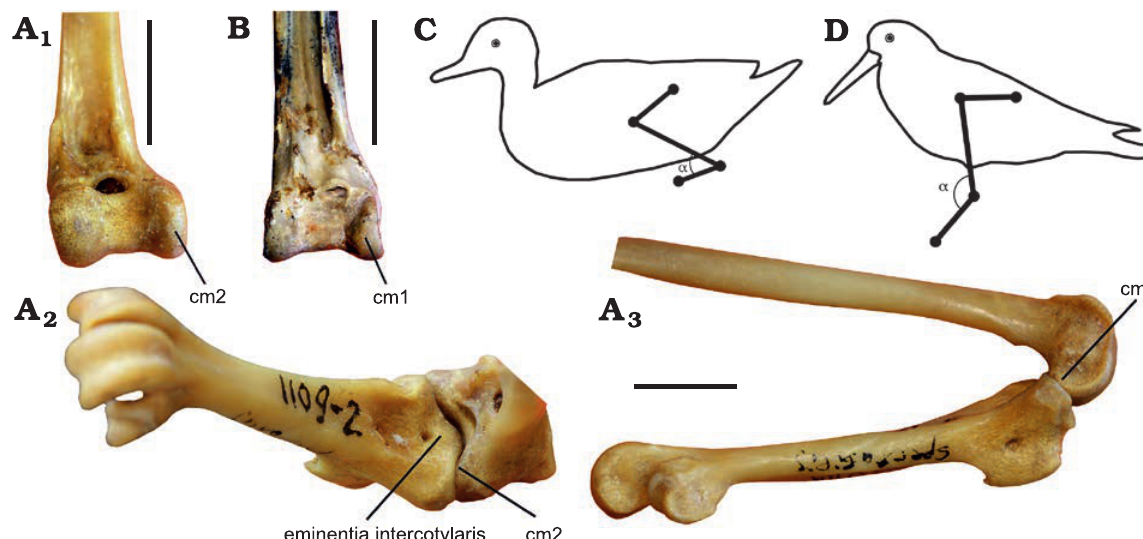
Fig. 3. The intertarsal joint of Recent Anatidae (exemplified by Somateria spectabilis (Linnaeus, 1758), PIN 41-2-2; A ) and fossil wading bird (PIN 3104-65; early Eocene of Tsagaan-Khushu locality; southern Mongolia; B ) as related to the swimming locomotion. Two types of the general structure of the distal tibiotarsus (A 1 , B), illustrating the difference in the shape of the condylus medialis (cm1, cm2). Maximal anatomically possible dorsiflexion of the tarsometatarsus in Anatidae, in craniomedial view (A 2 , showing full contact between the condylus medialis type 2 and the articular surface of the tarsometatarsus), in medial view (A 3 ). Position of the tarsometatarsus relative to the tibiotarsus at the beginning of the propulsive phase of the stride in swimming duck ( C ) and walking wader ( D ); note the strongly dorsiflexed tarsometatarsus in the former (modified after Provini et al. 2012; Killbourne et al. 2016). Abbreviations: cm1, cm2; condylus medialis in type 1 and type 2 intertarsal joints (see text). Scale bars 10